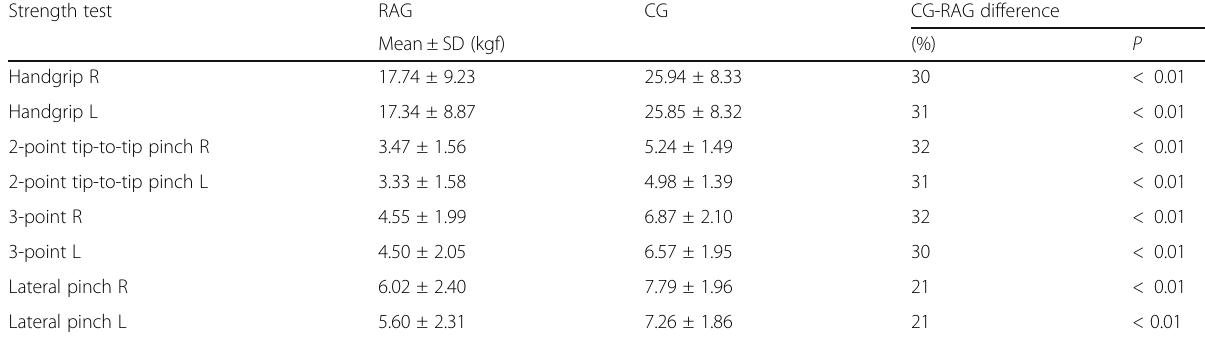
Table 2 Hand strength of participants in the rheumatoid arthritis group (RAG) and the control group